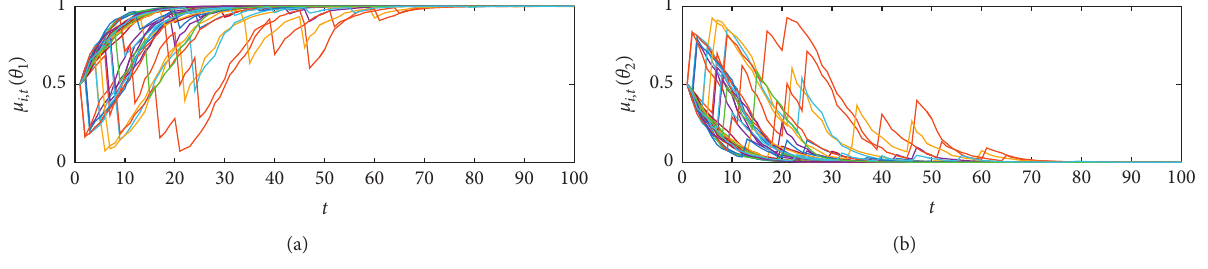
Figure 2: Individual Bayesian learning results.